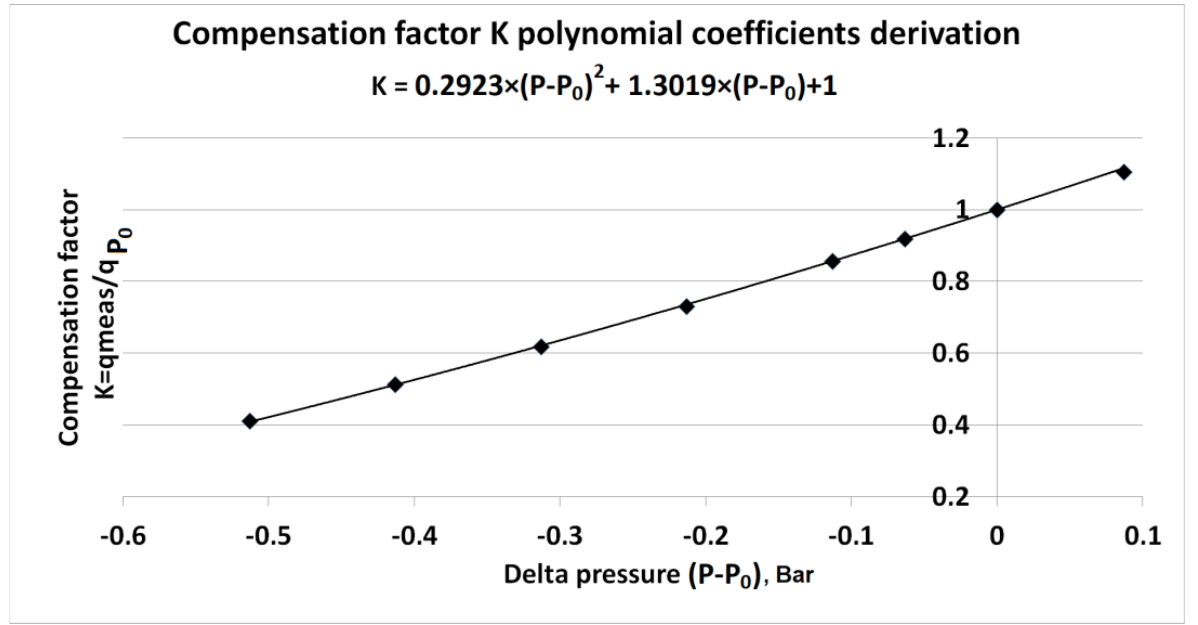
Figure 3. Pressure calibration procedure for deriving compensation factor function K with respective polynomial coefficients A = 0.2923 Bar −2 and B = 1.3019 Bar −1 .